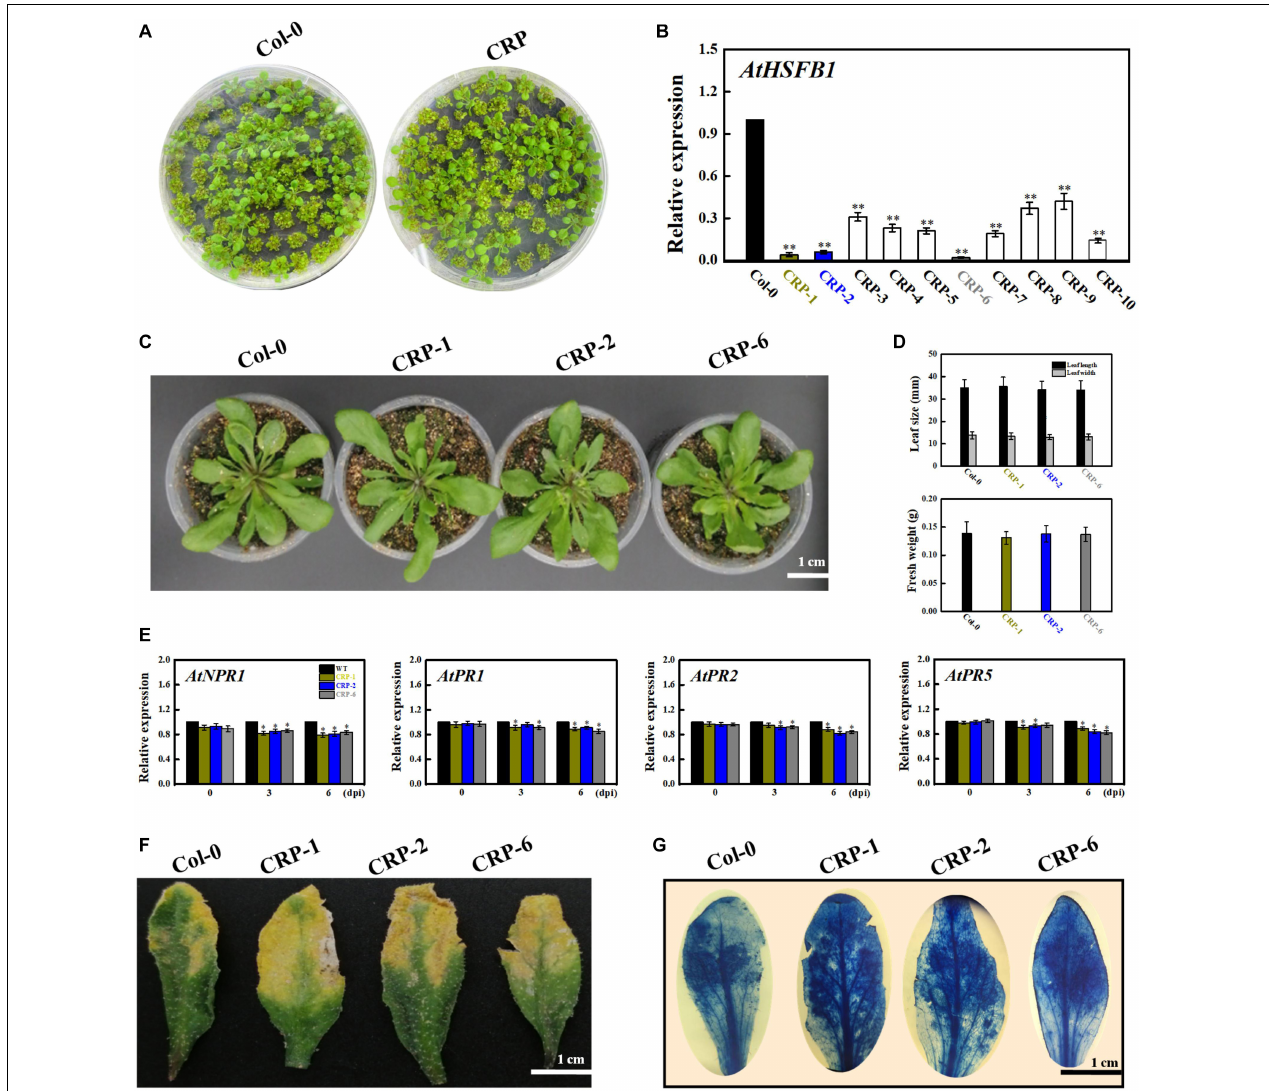
FIGURE 8 | HSFB1 mutation mediated by the CRISPR/Cas9 system scarcely modifies the fungal resistance of Arabidopsis to B. cinerea . (A) Growth phenotypes of Arabidopsis Col-0 wildtype and mutant seedlings at 15 days after sowing on MS plants. (B) Transcript levels of HSFB1 from Col-0 wildtype and CRISPR mutants grown in soil for more than 4 weeks. Transcript amounts are normalized against the AtActin2 value, and the results are expressed as the mean ± SE. Asterisks indicate that the differences between wildtype and CRISPR mutants are statistically extremely significant at the p = 0.01 level. (C,D) CRISPR mutants (CRP1, CRP2, and CRP6) show unchanged levels of leaf length and biomass compared with Col-0 wildtype. Bar = 1 cm. (E) Relative mRNA levels of NPR1, PR1 , PR2, and PR5 genes in Col-0 wildtype and CRISPR mutants (CRP1, CRP2, and CRP6) after inoculation with B. cinerea at 0, 3, and 6 days. Asterisks represent significant differences between wildtype and CRP1, CRP2, or CRP6 at p = 0.01. (F) Disease symptoms of Col-0 wildtype and CRISPR mutants (CRP1, CRP2, and CRP6) at 6 dpi. Bar = 1 cm. (G) Necrotic areas in wildtype and CRISPR mutants were stained with trypan blue and recorded by a camera mounted on a binocular